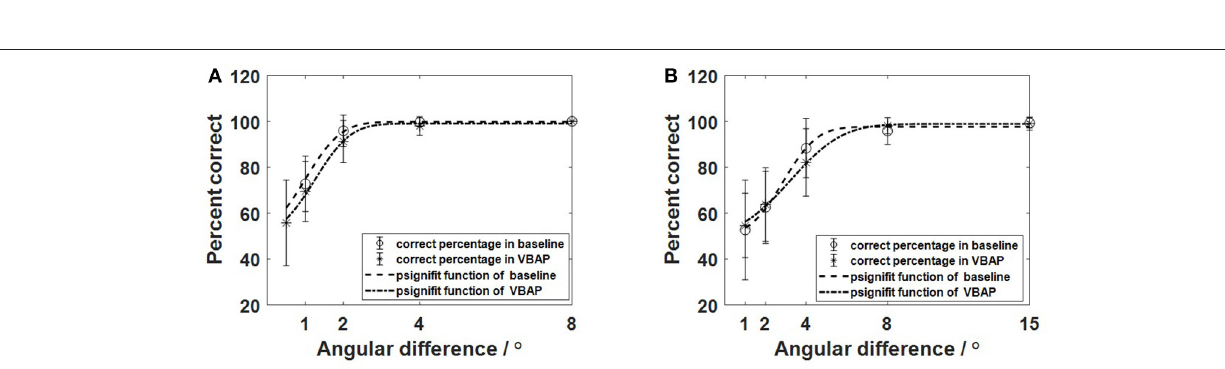
FIGURE 3 | Comparison of the results of the two methods. (A) The results of the frontal MAA measurement experiment; (B) The results of the lateral MAA measurement experiment.